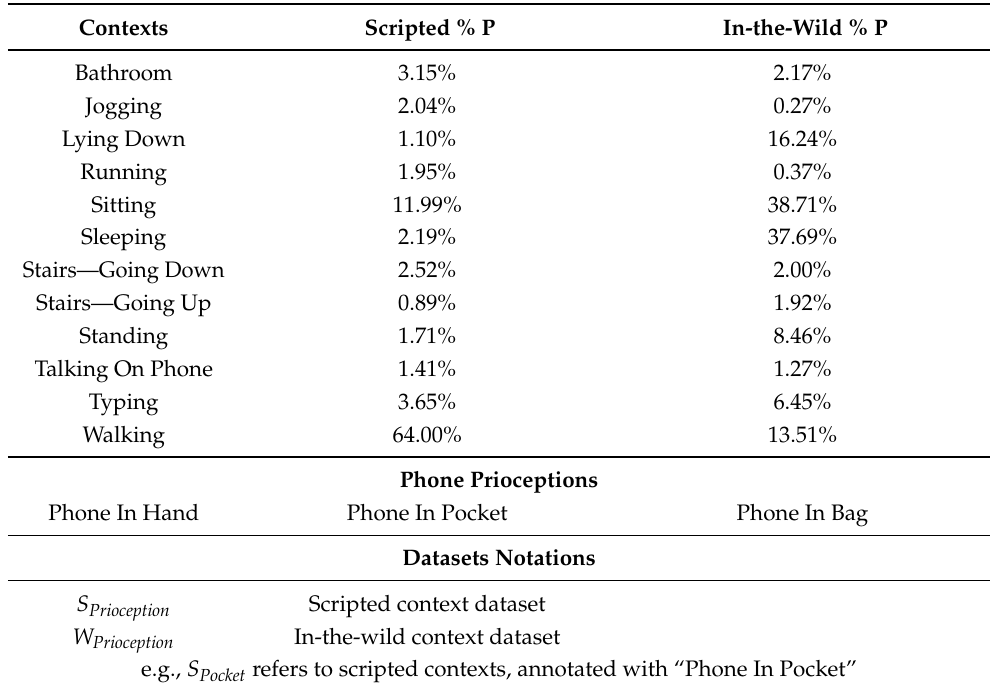
Table 5. The proportions of contexts that have been given a positive